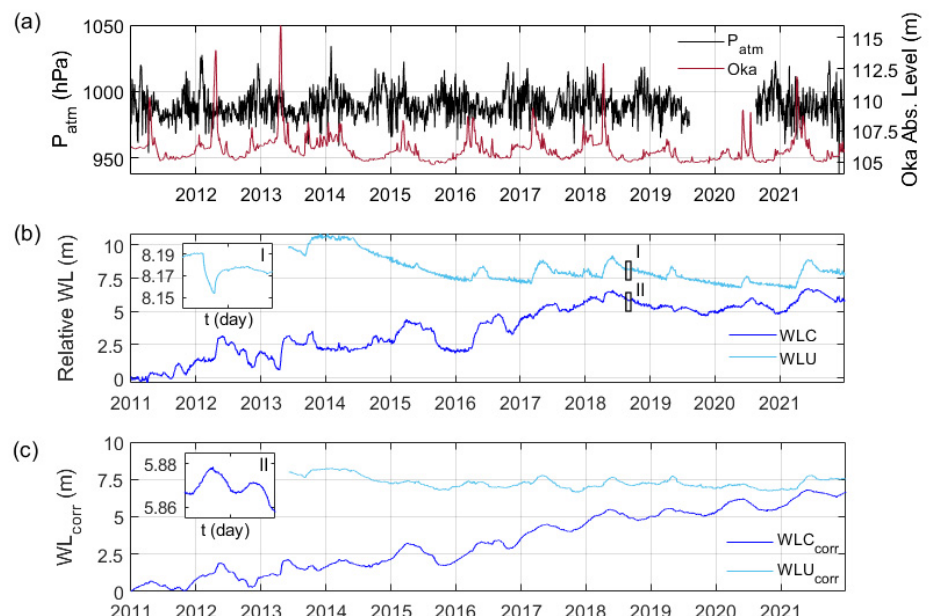
Figure 2. Diagrams of the atmospheric pressure and the level of the Oka river ( a ), initial groundwater levels ( b ) and corrected groundwater levels of WLC and WLU aquifers ( c ) (“corrected” means that barometric and tidal impacts in the range of periods 8–36 h are removed). Box I—local mini- depression cone in initial data of the WLU aquifer; box II—tides in initial data of WLC aquifer. The regime of the Kashirsky aquifer is disturbed due to aquifer exploitation.